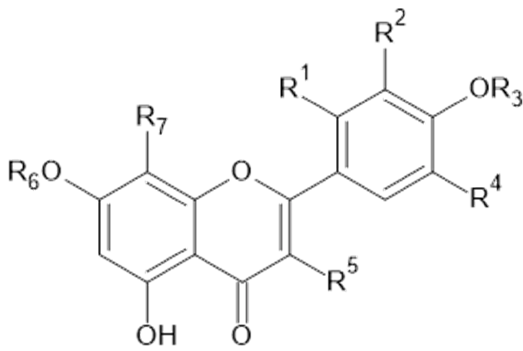
Figure 3. Quercetin and derivatives.